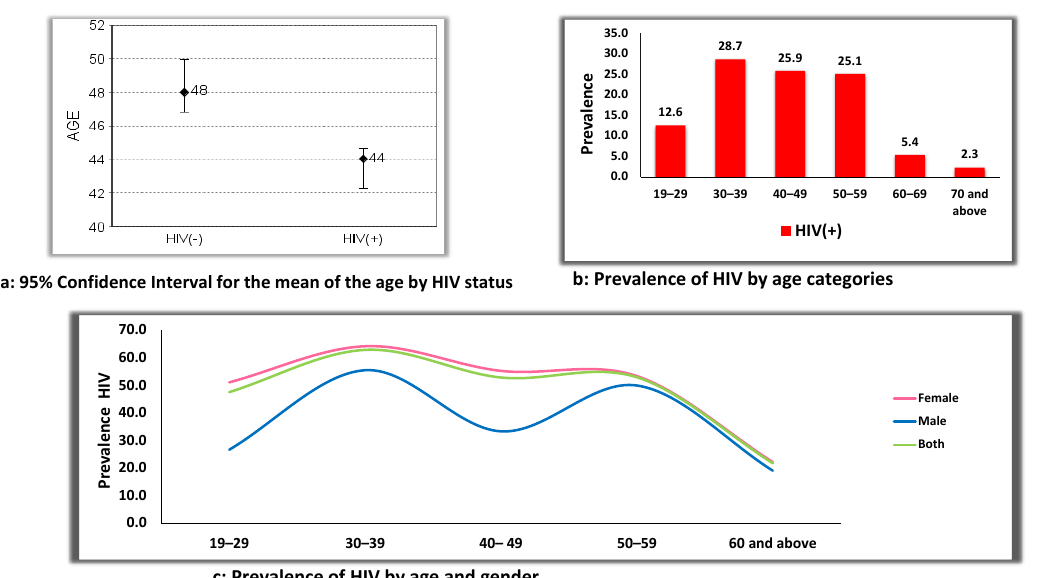
Figure 3. ( a – c ): Prevalence of HIV by age and gender.